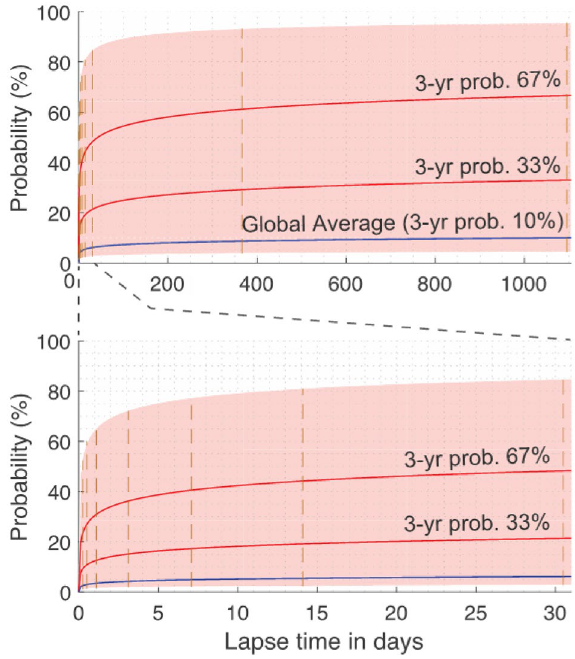
Figure 4. Cumulative probability curve for successive occurrence of great Nankai megathrust earthquakes. Two red curves show the cumulative probability corresponding to 3-year probabilities of 33 and 67%. The red-shaded area shows the confidence interval; minimum and maximum limits corresponding to 3-year probabilities of 4.3 and 96%. The blue curve corresponds to the cumulative probability from global statistics, with 3-year probability of 10%. The vertical broken lines in orange indicate the 95% confidence intervals for different time frames (Table 1).